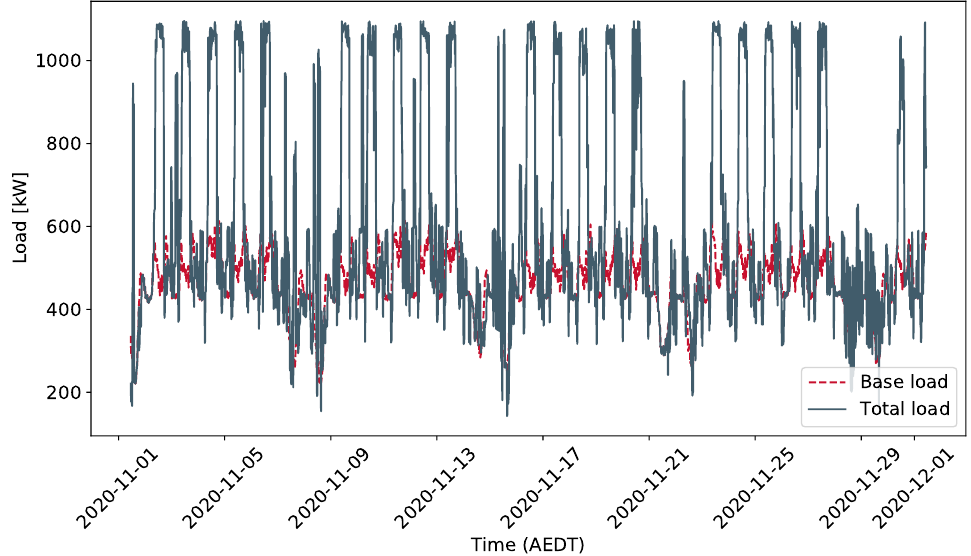
Figure 8. Predicted base load and total load resulting from the schedule for problem instance small1. Once-off activities are scheduled on weekends and at the end of the planning horizon (on a Monday and part of a Tuesday) since no recurring activities take place at these times, and thus the peak load is not increased by the once-off activities. The load of the recurring activities on the working days of the full weeks of the planning horizon is well-distributed, resulting in similar peak loads on all days of the full weeks. Figure 9 shows the real base load and the total load resulting from the same schedule. As one can see, the peaks are no longer similar on the different working days of the full weeks, and the total peak occurs on the 11th of November (which is also the case for all other problem